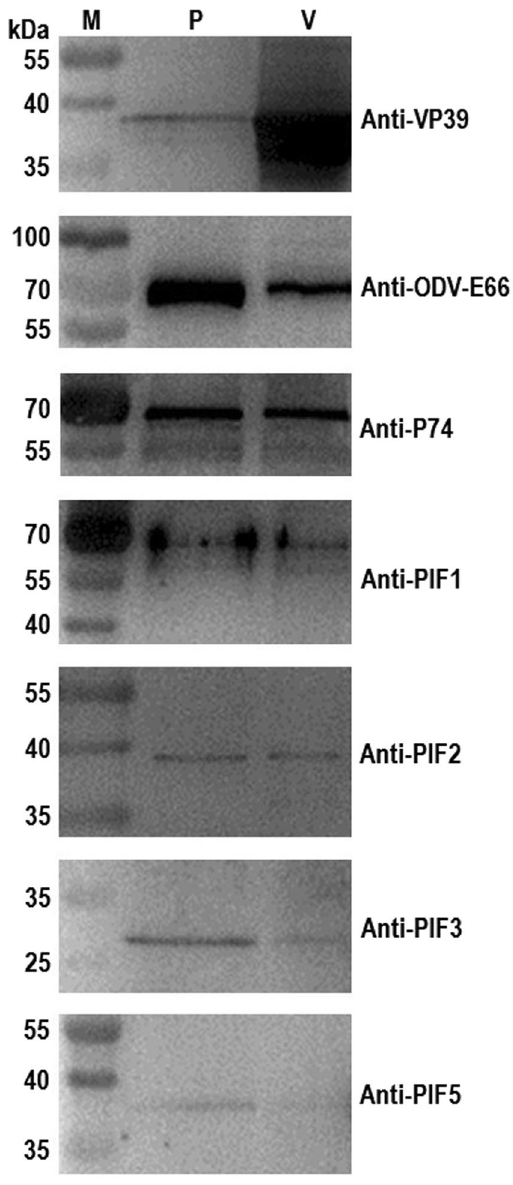
Figure 4. Certain proteins associated with ODV were detected in the polyhedra matrix. The polyhedra matrix (lane P) and ODV (lane V) fractions were loaded for the Western blot analyses. The antibodies used for the blotting were described previously 17 and indicated to the right of each blot diagram. Lane M, the protein